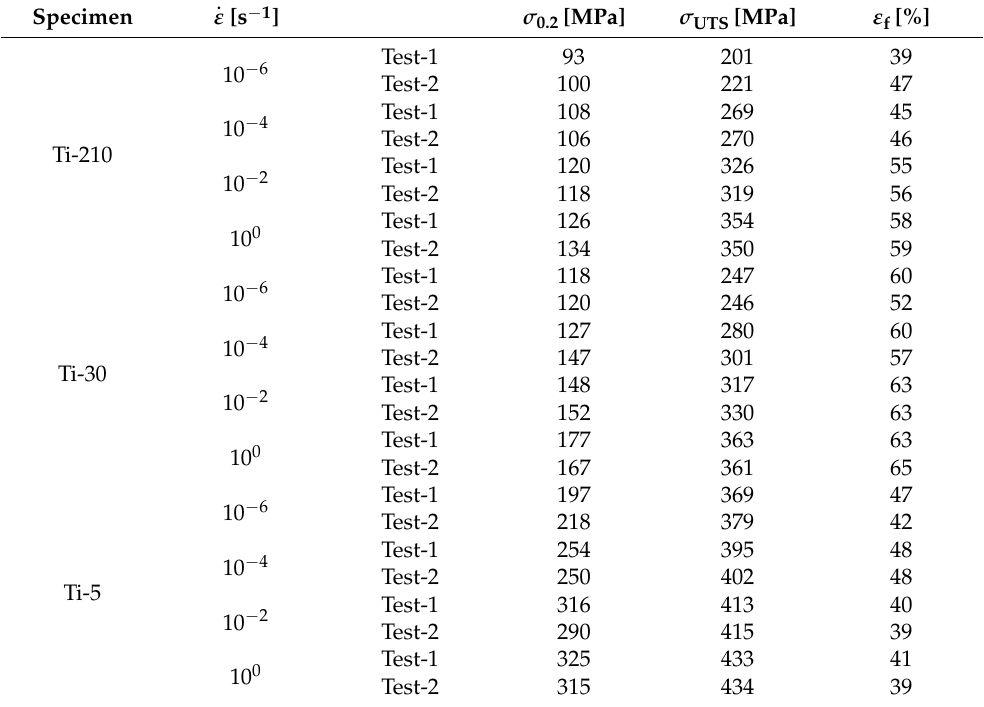
Figure 3. Nominal stress-nominal strain curves of ( a ) Ti-210, ( b ) Ti-30, and ( c ) Ti-5 obtained from tensile tests performed at room temperature at strain rates ranging from 10 − 6 to 10 0 s − 1 . Table 2. Mechanical properties obtained from tensile tests.